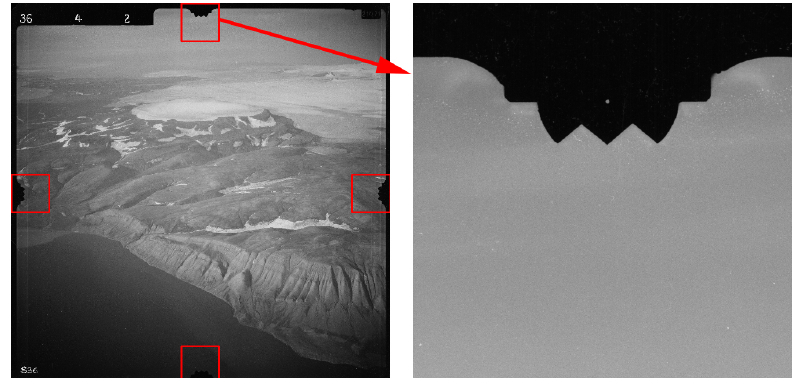
Figure 3. Fiducial mark in an image from 1936 over Svalbard and a close-up of the top one.